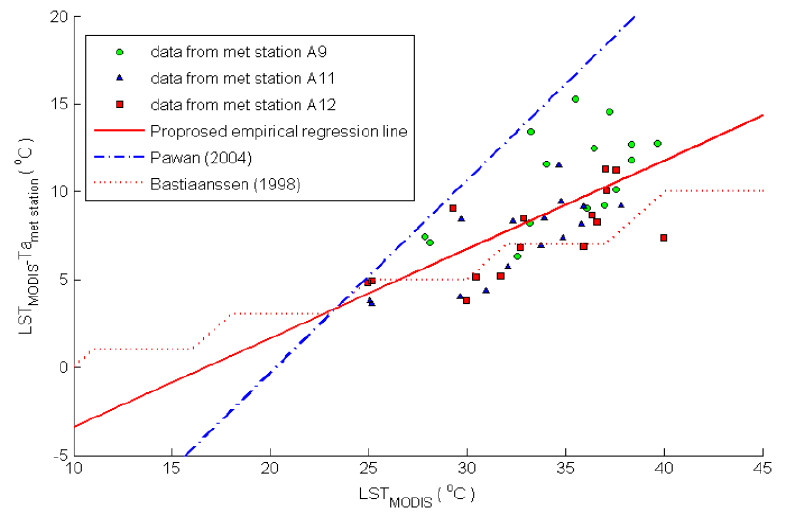
Figure 3. Three alternative equations relating surface temperature ( Ts ) to the air to surface temperature difference ( dT